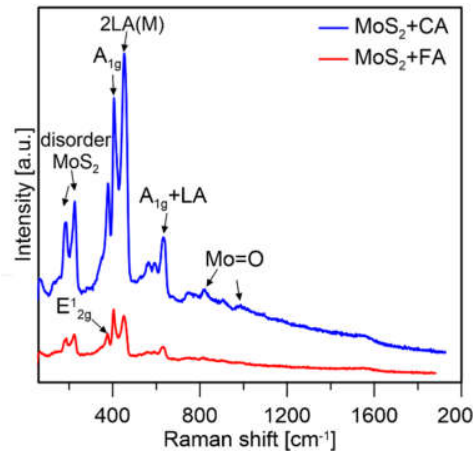
Figure 9. Raman spectra of MoS 2 prepared with citric (CA) and formic acid (FA).